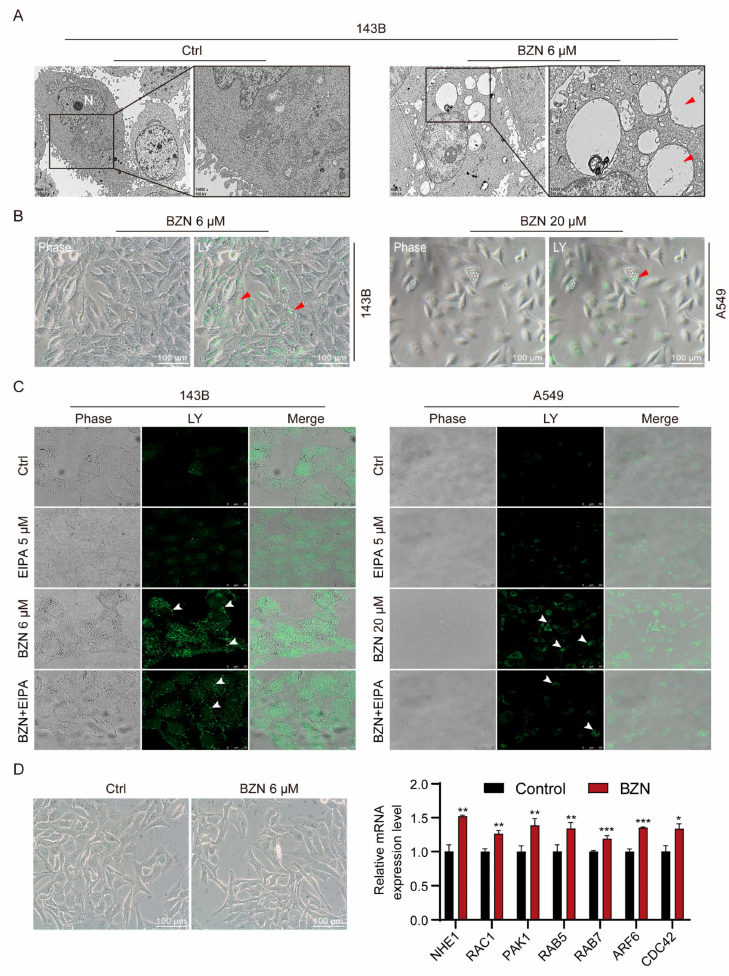
Figure 7. BZN induces macropinocytosis in OS cells. ( A ) Representative images of cellular ultra- structures in BZN-treated 143B cells (transmission electron microscopy, scale bars: 1/2 µ m). Vacuolar ultrastructure is indicated by red arrows. N: Nucleus. ( B ) Representative images of Lucifer yellow (LY) in 143B OS cells and A549 lung cancer cells (scale bars: 100 µ m). Red arrows indicate the LY localized in vacuoles. ( C ) The effect of EIPA on the LY uptake of 143B and A549 cells (laser confocal microscopy, scale bars: 25/50 µ m). White arrows indicate the accumulated LY particles. ( D ) The mRNA expression levels of macropinocytosis-related genes (Q-PCR, right panel), and the corresponding cell morphology at this time (left panel, scale bars: 100 µ m). Data are shown as mean ± SD from three